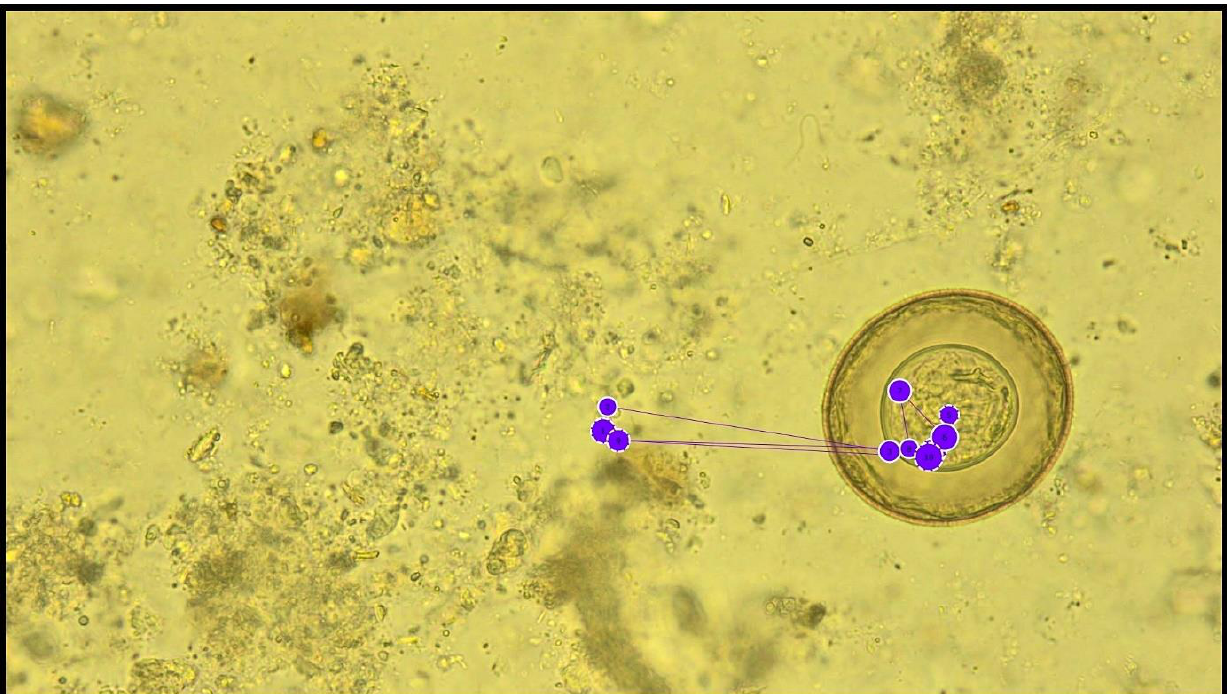
Figure 5. Example of incorrect, too narrow analysis of a preparation. Dot-fixation (eye hold); dot diameter is directly proportional to the time the eye is held. Line-saccade (quick shift of eyesight from one point to another).